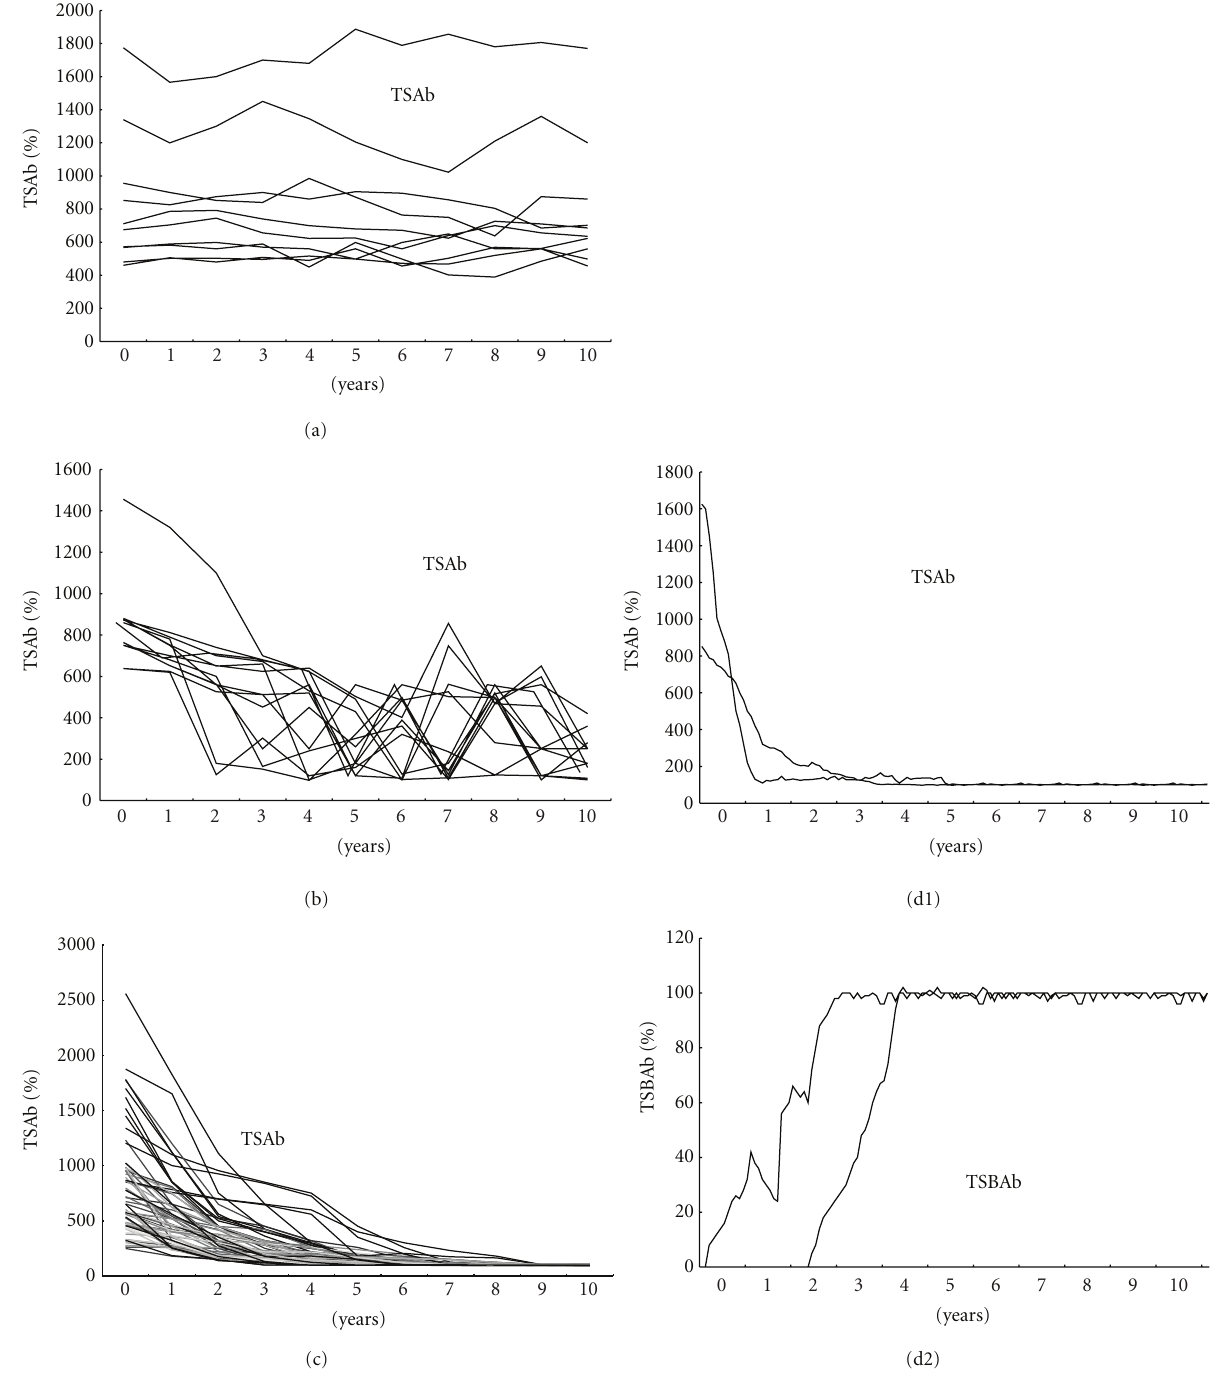
Figure 3: The changes of TSAb in 98 Graves’ patients with hyperthyroidism (II) (Table 1, II). Among the 98 Graves’ patients with hyperthyroidism, 10 patients continued to have persistently positive TSAb and continued to have hyperthyroidism (Table 1, IIa) (a). Ten of the 98 TSAb-positive Graves’ patients with hyperthyroidism continued to have persistently positive TSAb. They continued to have hyperthyroidism and did not get remissions of Graves’ hyperthyroidism. They continued to take MMI. Complex changes of TSAb were noted in 13 TSAb-positive patients (Table 1, IIb) (b). One of the 13 patients with complex changes of TSAb got remissions, but the other 12 patients did not get remissions. TSAb disappeared in 73 (74%) of the 98 TSAb-positive Graves’ patients with hyperthyroidism (Table 1, IIc) (c). With the disappearance of TSAb, 60 (82%) of the 73 patients, in whom TSAb had disappeared, got remissions of Graves’ hyperthyroidism. (d1, d2) show the changes of TSAb and TSBAb, respectively, in the 2 patients with TSAb-positive Graves’ hyperthyroidism, who developed TSBAb-positive hypothyroidism (Table 1, IId). In these 2 patients, TSAb was dominant initially (d1), and then TSBAb became dominant (d2). Two patients with TSAb-positive Graves’ hyperthyroidism developed TSBAb-positive hypothyroidism. Graves’ hyperthyroidism was treated with MMI, and hypothyroidism was treated with